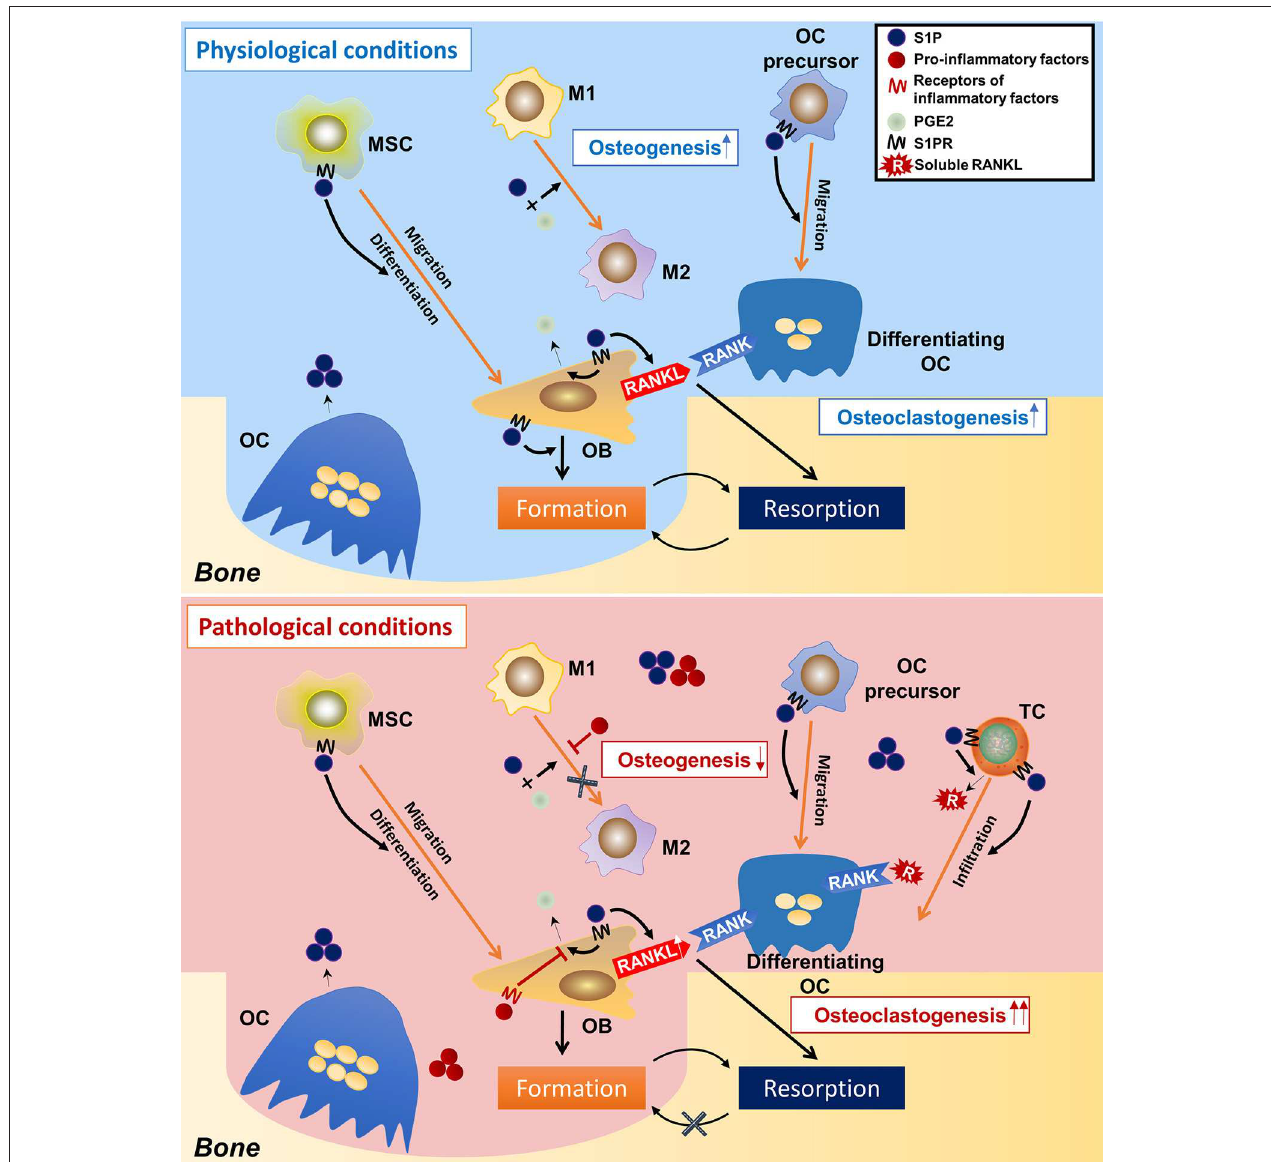
FIGURE 4 | Speculations on the regulatory roles of S1P on osteoimmunology under physiological and pathological conditions. In the physiological condition, osteoclast-derived S1P initiates bone formation by triggering MSCs migration to the resorption cite and by inducing osteoblasts differentiation. During the osteogenic process, S1P also induces the production of PGE2, which, together with S1P, leads the polarization of macrophages toward the M2 phenotype, thereby facilitating bone formation. S1P also induces RANKL production of osteoblasts, as well as the migration of osteoclast-precursors, initiating a new round of osteoclastogenesis. This makes the constant remodeling and bone metastasis. However, in the pathological condition (inflammation), the over-accumulated S1P results in infiltration of inflammatory cells (i.e., T-helper cells), which not only secret large amounts of pro-inflammatory cytokines, but also produce a lot of RANKL (in stimulation of S1P), which greatly induces osteoclastogenesis. On the other hand, the pro-inflammatory factors neutralize the immune-suppressive function of S1P and PGE2 on macrophages, result in failed conversion from M1 to M2 phenotype–an unsuitable circumstance for osteogenesis. This eventually makes to the imbalance between bone resorption and formation and thereby bone loss. S1P, sphingosine-1-phosphate; S1PR, sphingosine-1-phosphate receptor(s); MSC, mesenchymal stem cell; M1/M2, M1/M2 macrophage; OC, osteoclast; OB, osteoblast; TC, T cell; PGE2, prostaglandin E2.